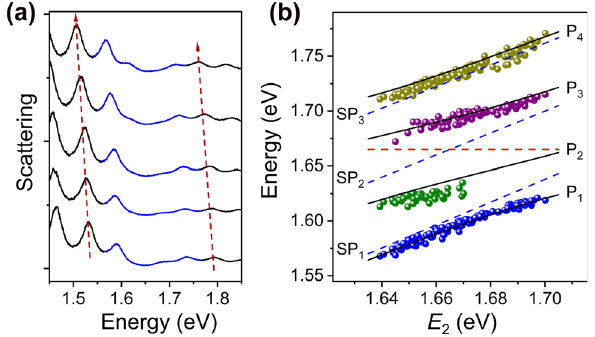
Figure 2: Analyses of scattering spectra for Ag NW-WSe coupled 2 with Al O systems. (a) Scattering spectra of a Ag NW on monolayer WSe 2 2 3 of different thickness. The thickness of Al O is 5 nm, 5.6 nm, 6.6 nm, 2 3 8.6 nm, and 10.6 nm from bottom to top. The red arrows mark the and SP modes. The strong coupling regions are drawn by redshift of SP L H blue curves. (b) Energies of P , P , P , and P (blue, green, purple, and 1 2 3 4 mode E . The black dark yellow dots) as a function of the energy of SP 2 2 lines are calculated by the Hamiltonian of four-coupled-oscillators model = g = 22 meV, and g = 32 meV. The blue with coupling strength of g 1 3 2 ( E ), SP ( E ), and SP ( E ) as a dashed lines show the energies of SP 1 1 2 2 3 3 . The red dashed line indicates the transmission dip energy function of E 2 of excitons.